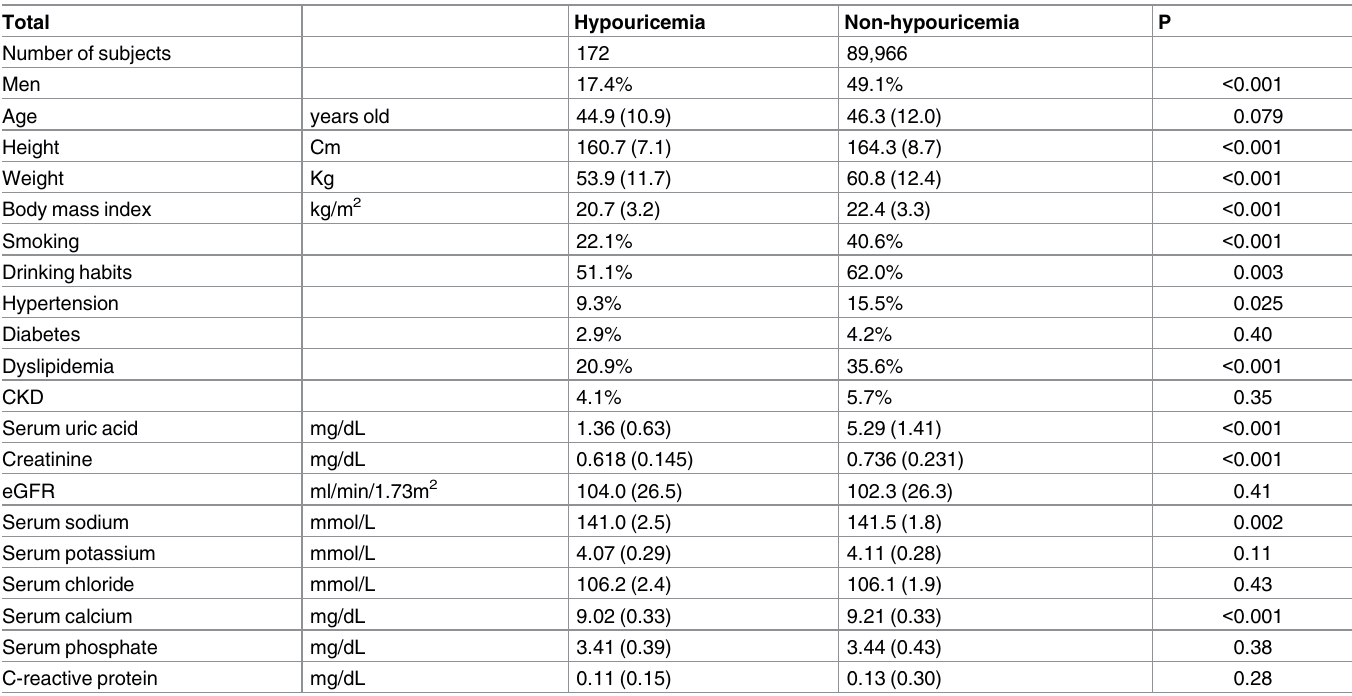
Table 1. Characteristics of the study